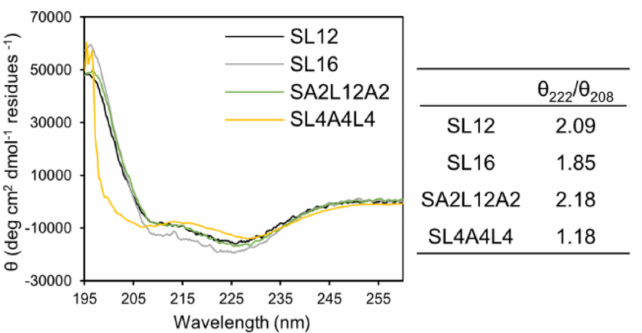
Figure 2. CD spectra and the ratios of θ 222 / θ 208 of peptide assemblies prepared from SL12, SL4A4L4, SA2L12A2, and SL16 in milli-Q